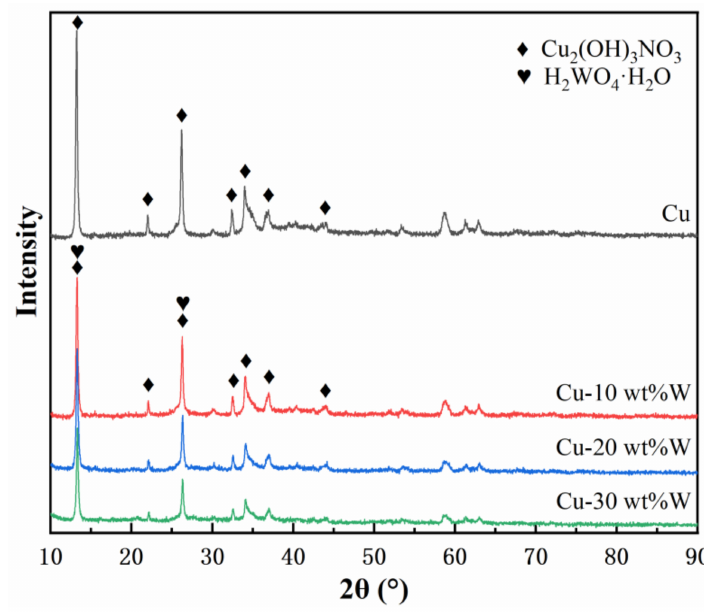
Figure 2. XRD patterns of precursor